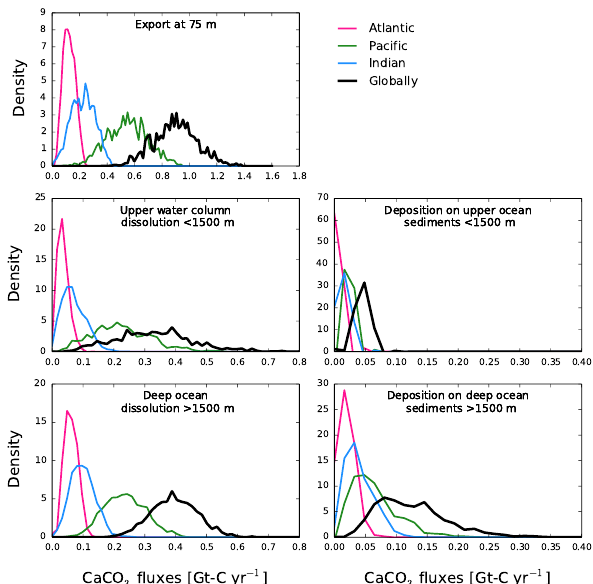
Figure 6. Probability density functions of basin-wide and global CaCO 3 fluxes as constrained by the observation-based TA ∗ distri- bution (corrected for a sediment burial flux of 0.12Gt Cyr − 1 ). Note the different scaling of the x axes.